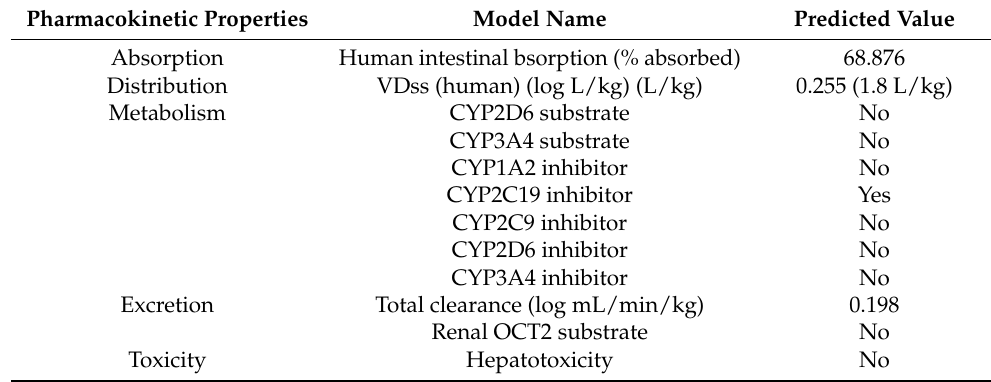
Table 1. Pharmacokinetic profile of buxifoliadine E predicted by in silico analysis (pKCSM program).